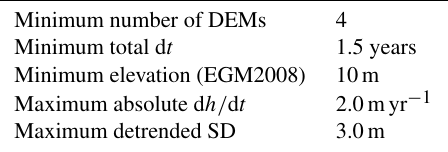
Table 3. Criteria used to identify dynamic control surfaces for least- squares DEM correction. See Fig. 5 for resulting map of dynamic control surfaces.